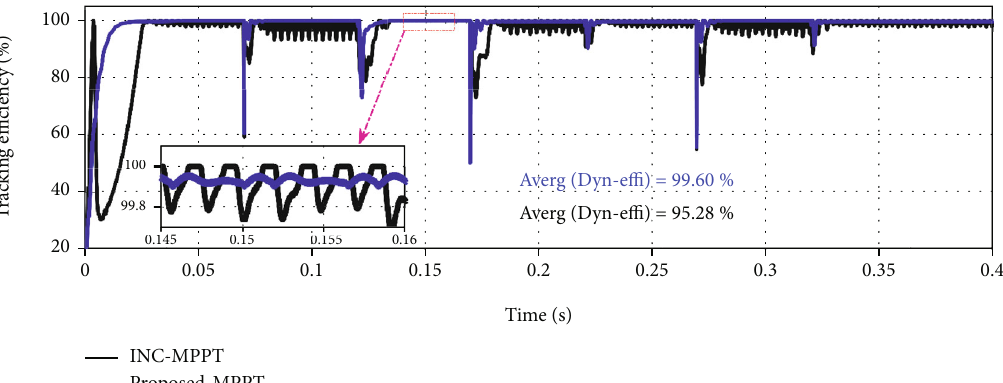
Figure 14: Dynamic e ffi ciency tracking of the simulation results.